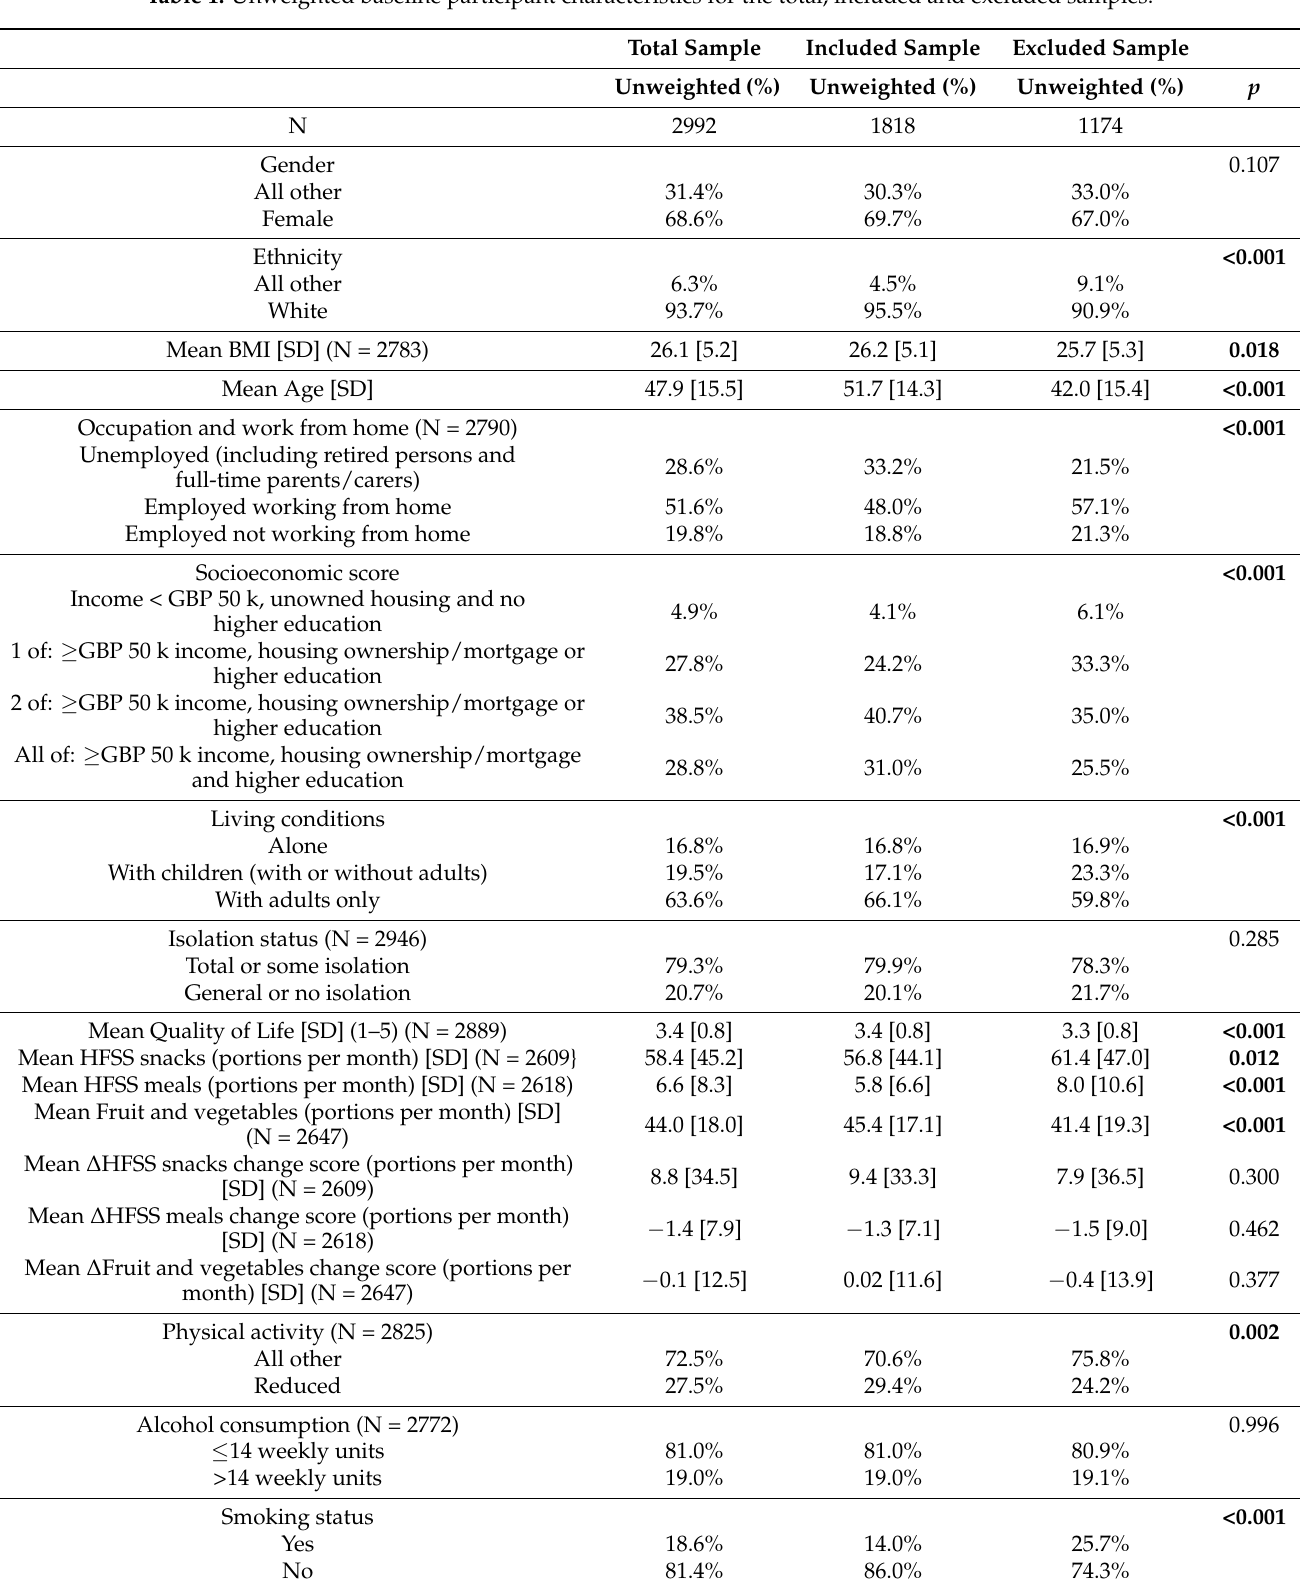
Table 1. Unweighted baseline participant characteristics for the total, included and excluded